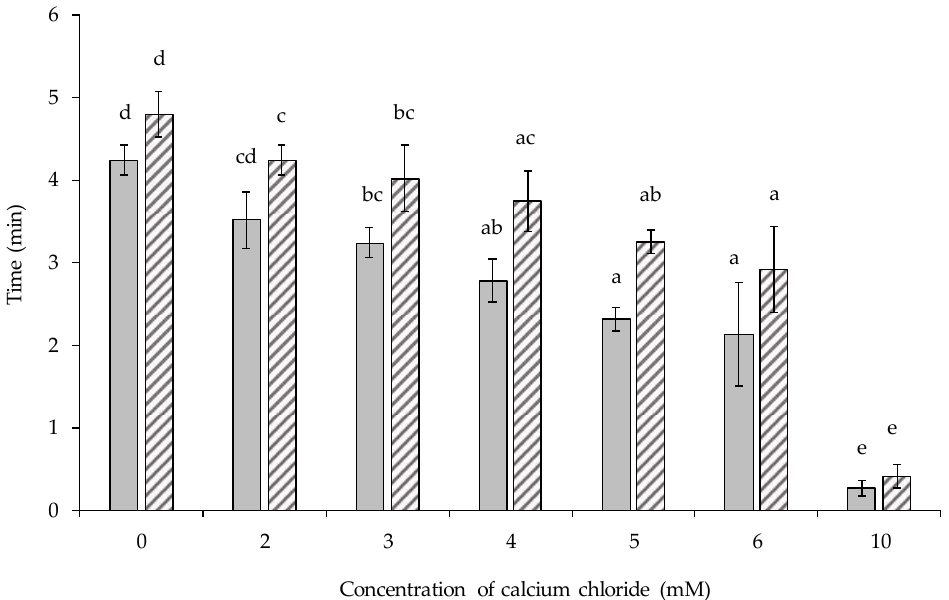
Figure 5. Influence of calcium chloride concentration on the heat onset ( ) and coagulation ( ) time of emulsions stabilised by lentil protein at pH 6.8. (a – e) The statistical analysis was performed between heat onset or coagulation time results at different [CaCl 2 ]; samples not sharing a common superscript differed significantly ( p ˂ 0.05).